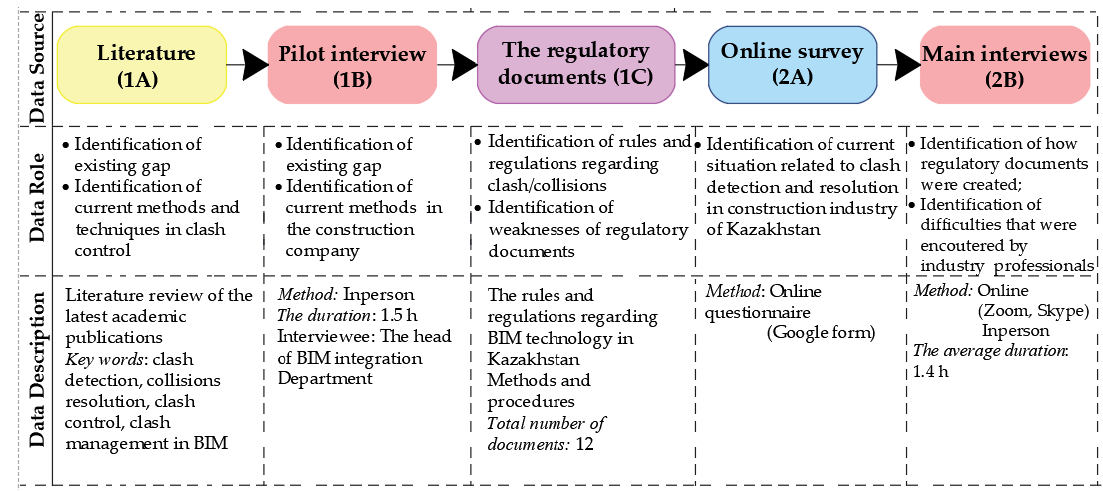
Figure 2. Data source summary.